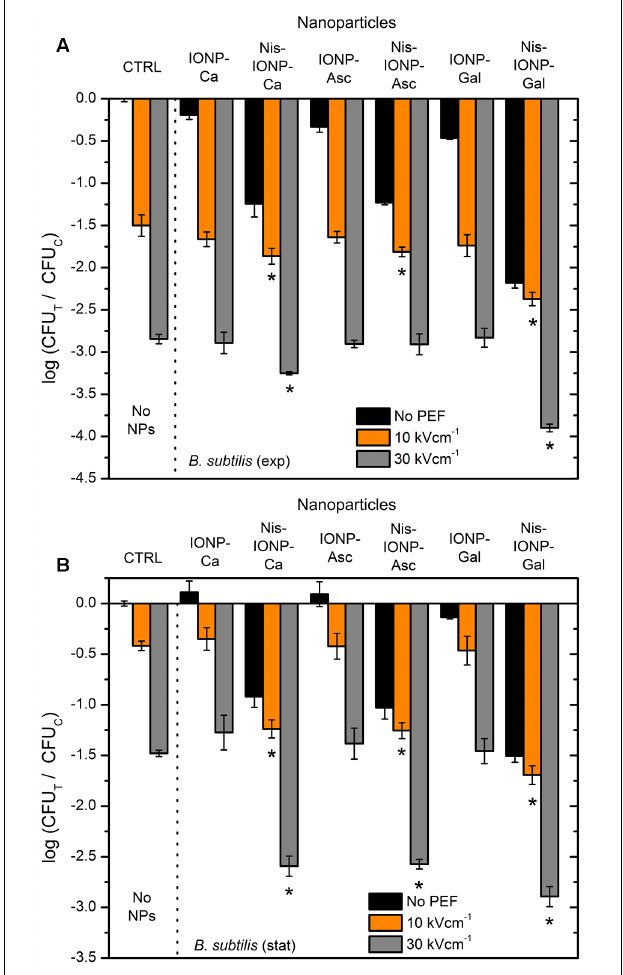
FIGURE 3 | Inactivation of Bacillus subtilis using different PEF protocols and NP, where (A) , exponential bacteria growth phase; (B) , stationary bacteria growth phase. CTRL, control samples without NPs; IONP, iron oxide nanoparticles; Nis, nisin-loaded. Different capping agents were used such as Ca, Asc, and Gal acids. The number of residual culturable cells in the samples after the PEF treatment (CFU T ) was compared with ones in the control samples without treatment (CFU C ). The asterisk ( ∗ ) represents statistically significant ( P < 0.05) difference versus untreated control.